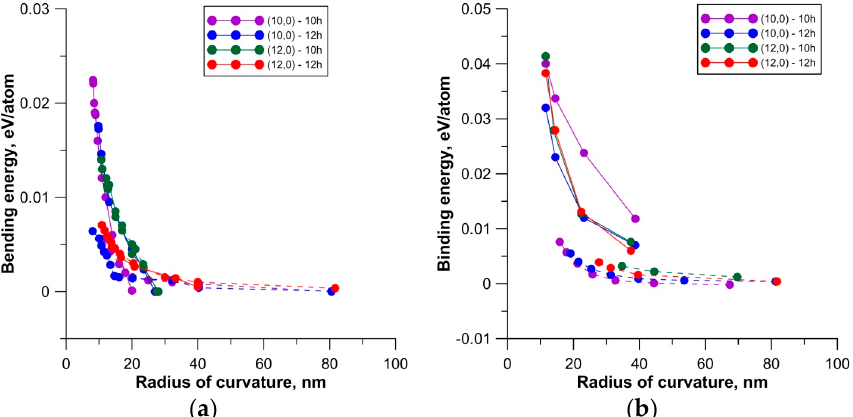
Figure 4. Dependence of the bending energy on a radius of curvature of the atomic network of graphene–CNT composite films: ( a ) a monolayer; ( b ) a bilayer. Solid lines correspond to the case of bending in the direction perpendicular to CNTs ( X -axis), while dashed lines represent bending along the CNT axis ( Y -axis).